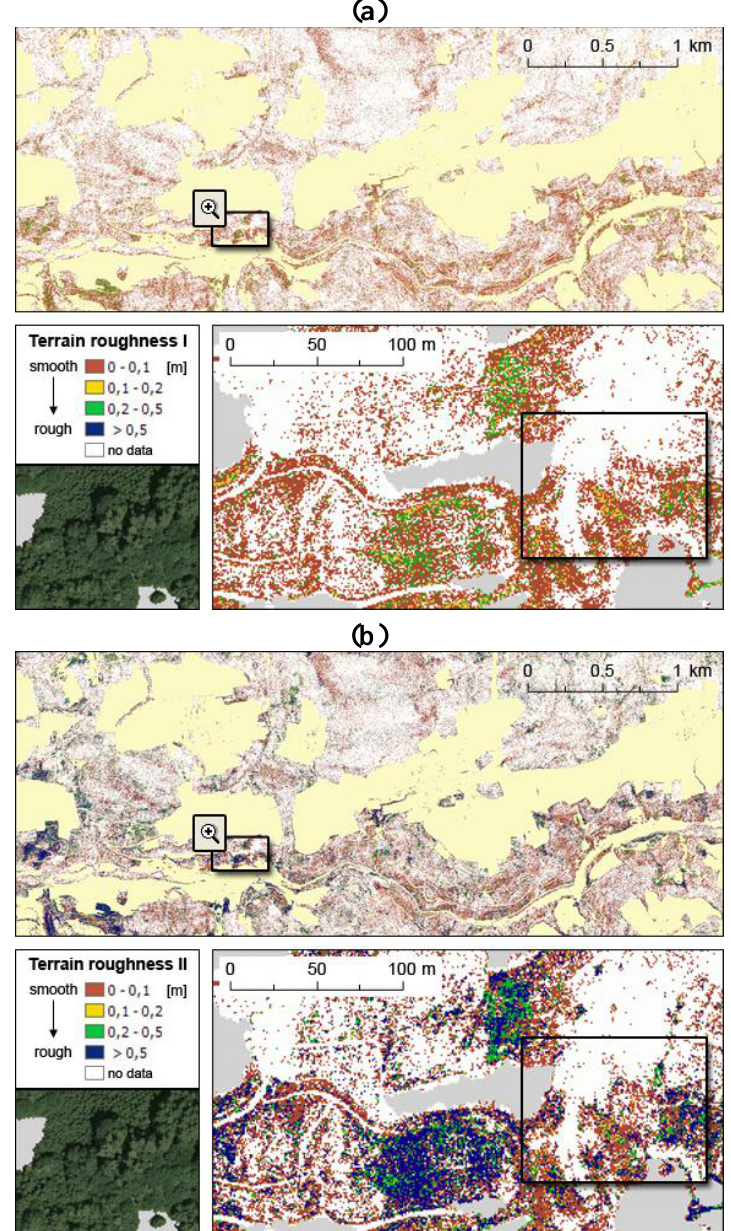
Figure 9. Terrain roughness: (a) TR I and (b) TR II for the test site Bucklige Welt